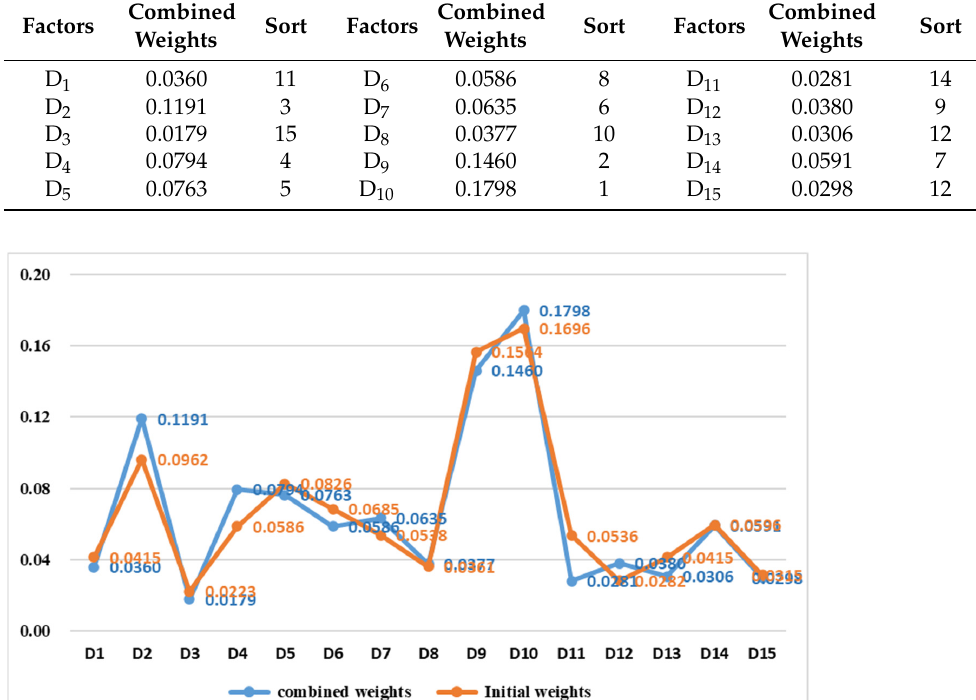
The initial weights and centrality of the risk factors are integrated according to Equation (15), such that the integrated weight values are obtained and ranked. The results are shown in Table 9. A comparison of the initial weights and combined weights of the lean green integration driver factors for manufacturing companies as can be seen below in Figure 4. Table 9. Combined weights of driving factors.